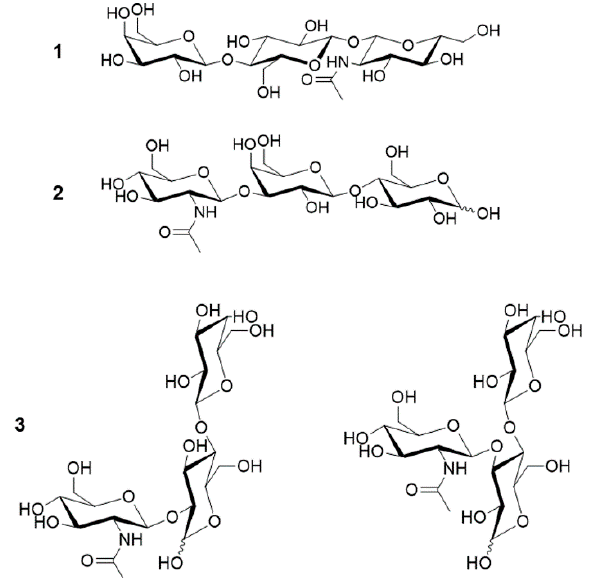
Figure 8. Structures of transglycosylation products determined by nuclear magnetic resonance (NMR).